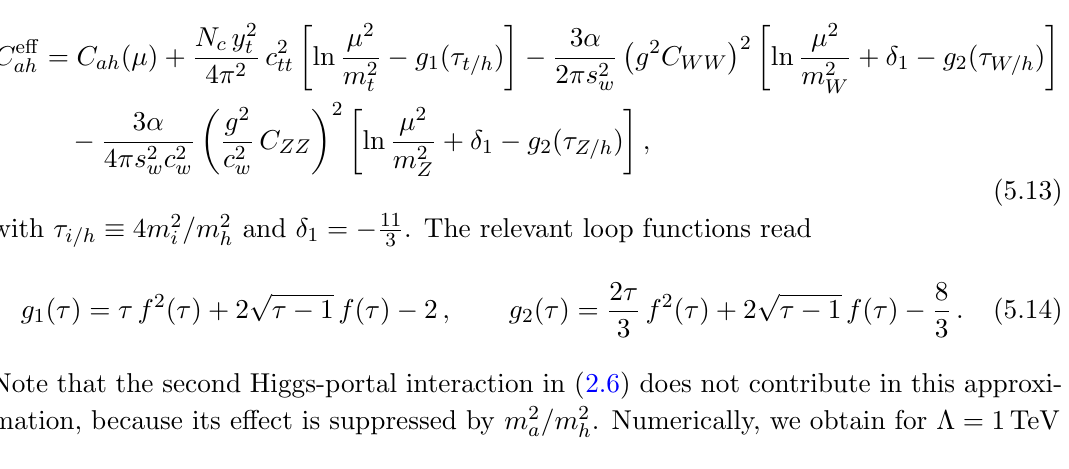
Figure 15 . Allowed region for the Wilson coe(cid:14)cients C e(cid:11) bound Br( h BSM) < 0 : 34 (orange) derived from the global analysis of Higgs decays [99]. The ! black dashed line shows the projected bound one would obtain for Br( h for 3000 fb (cid:0) 1 of integrated luminosity at p s = 14